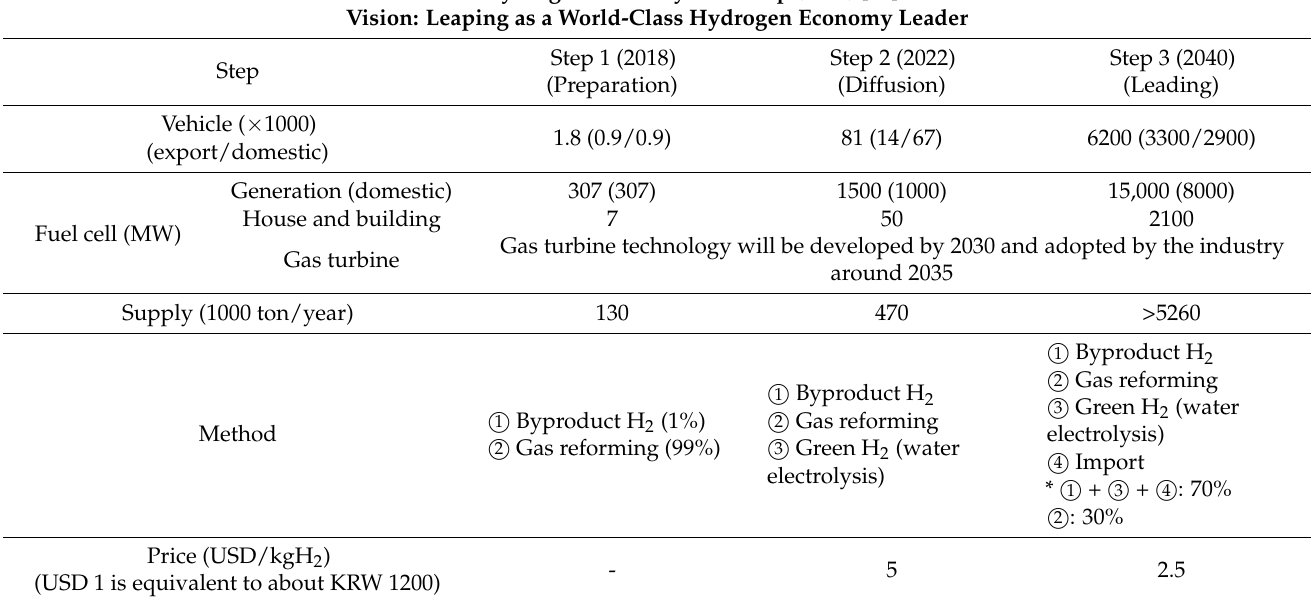
Table 2. Korea’s hydrogen economy roadmap [21].